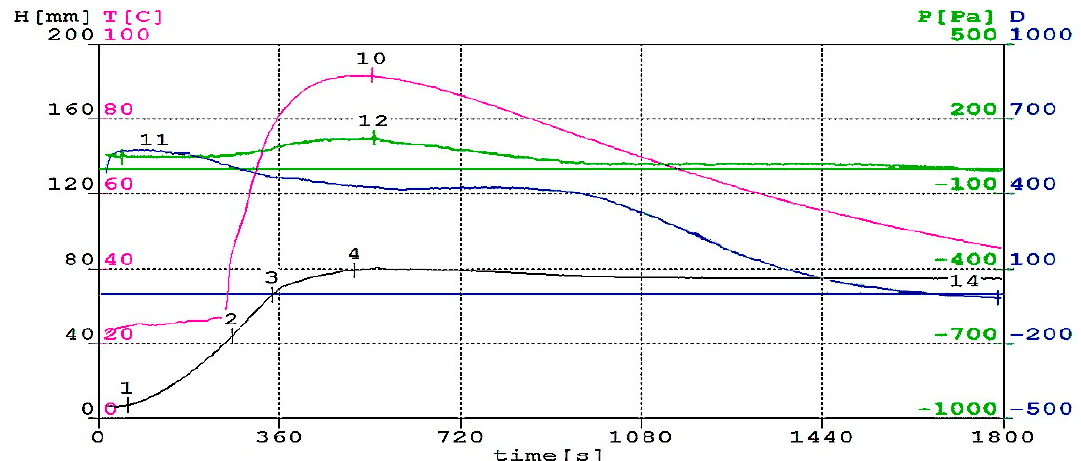
Figure 4. Change in height (H), temperature (T), pressure (p) and dielectric polarization (D) of reaction mixture during foaming process for M60 foam with 60 wt.% of biofiller.